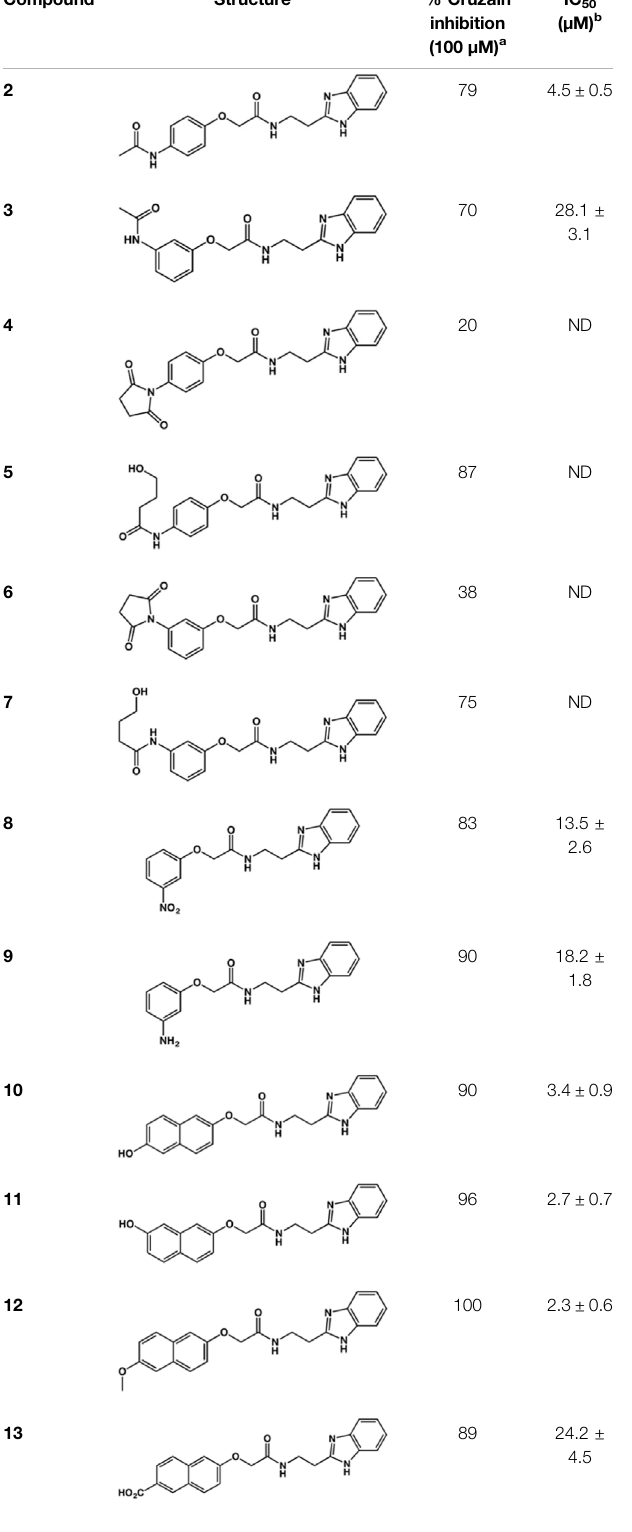
TABLE 2 | ( Continued ) Structure and activity against cruzain of new benzimidazoles with substituents at the phenyl ring. a